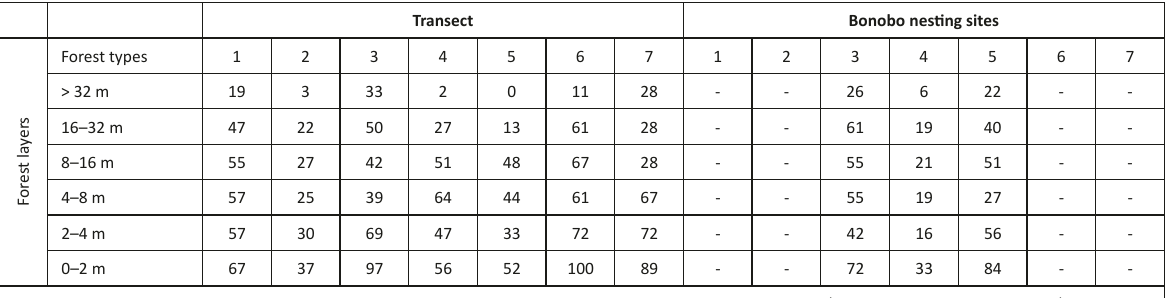
Table 1. Canopy cover (%) at different canopy heights compared between non-nesting sites and Bonobo nest sites in LTSF Transect Bonobo nesting sites Forest